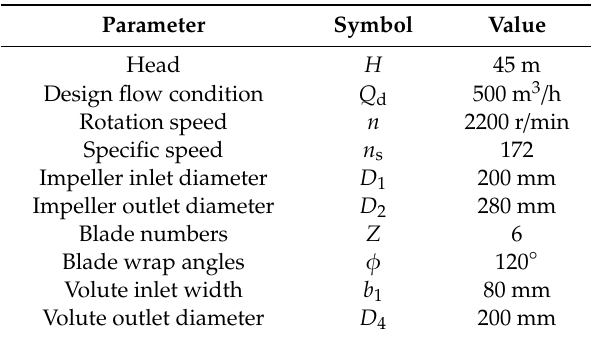
Figure 1. The structure and components of the pump. Table 1. Specifications of the pump.